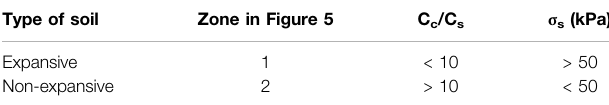
TABLE 2 | Classi fi cation of expansive soils based on C c /C s ratio and swelling pressure.